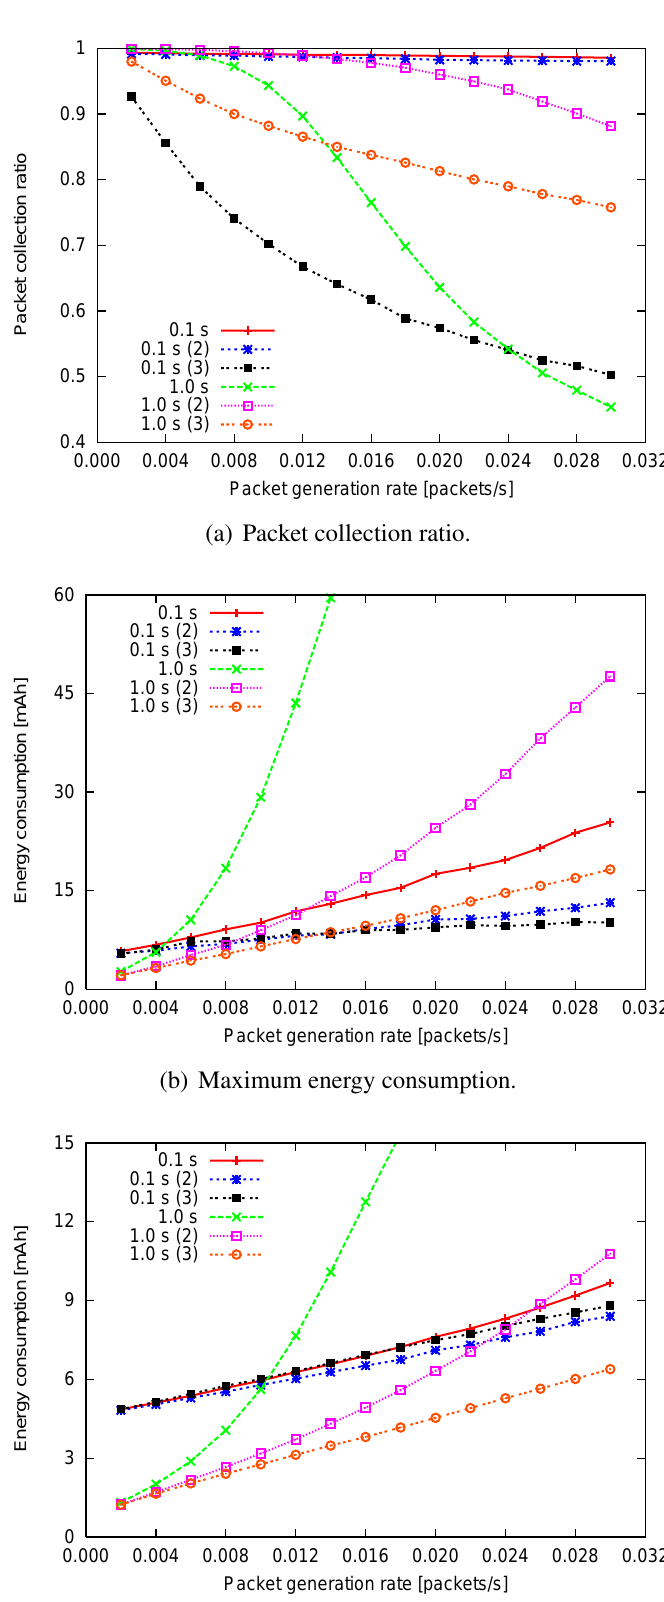
Figure 15. Performance with data